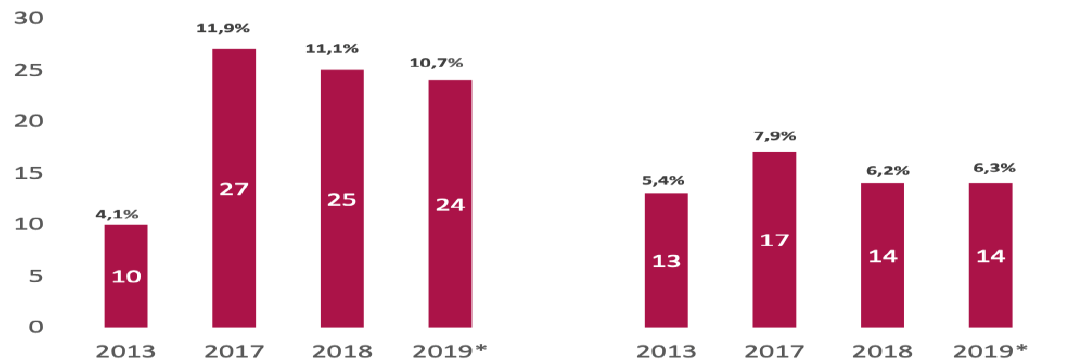
Figure 3. Women who are Chairman of the Board of Directors (left) or CEO (right) * Partial